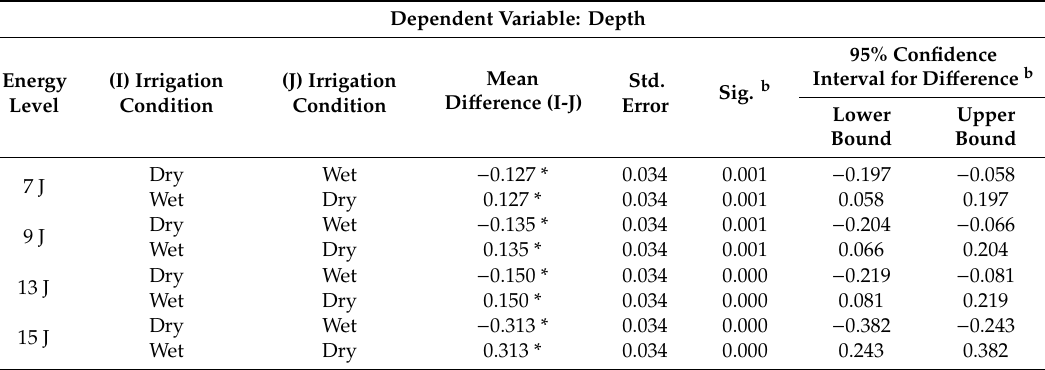
Table A7. Bonferroni-corrected post hoc tests (Irrigation Condition * Energy